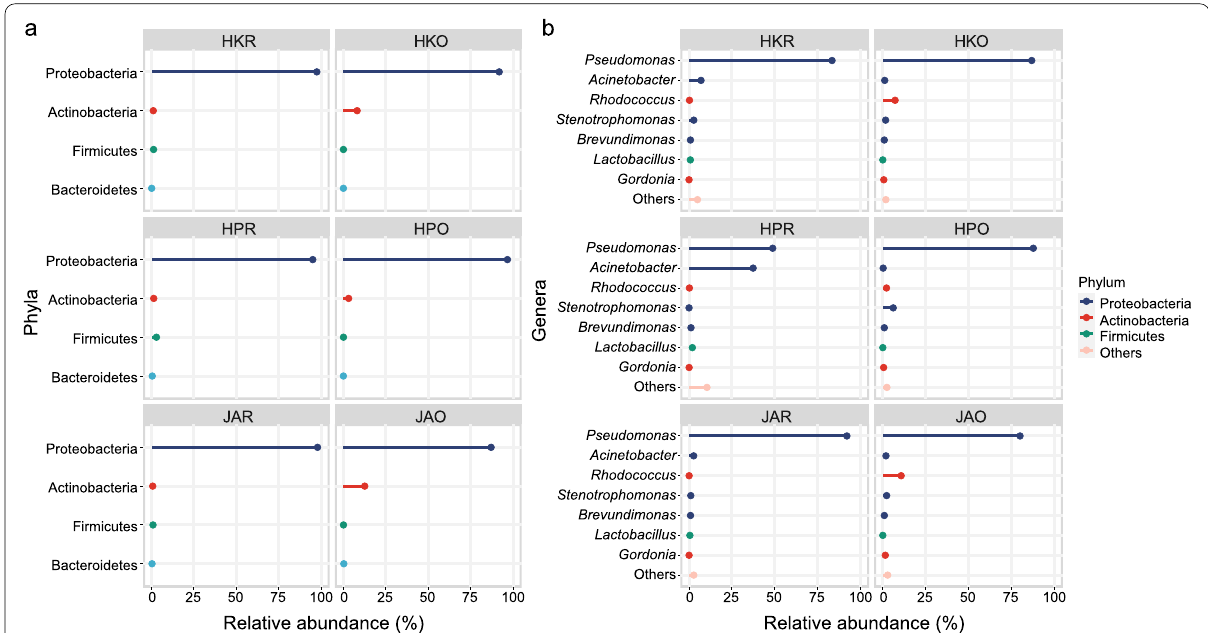
Fig. 1 Relative abundance of bacteria at phylum (a) and genus (b) levels at six sampling sites (waste reception halls of three transfer stations: HKR, HPR, JAR; top vents of three transfer stations: HKO, KPO, JAO). Genera belonging to the same phylum are represented by the same color as shown in the legend